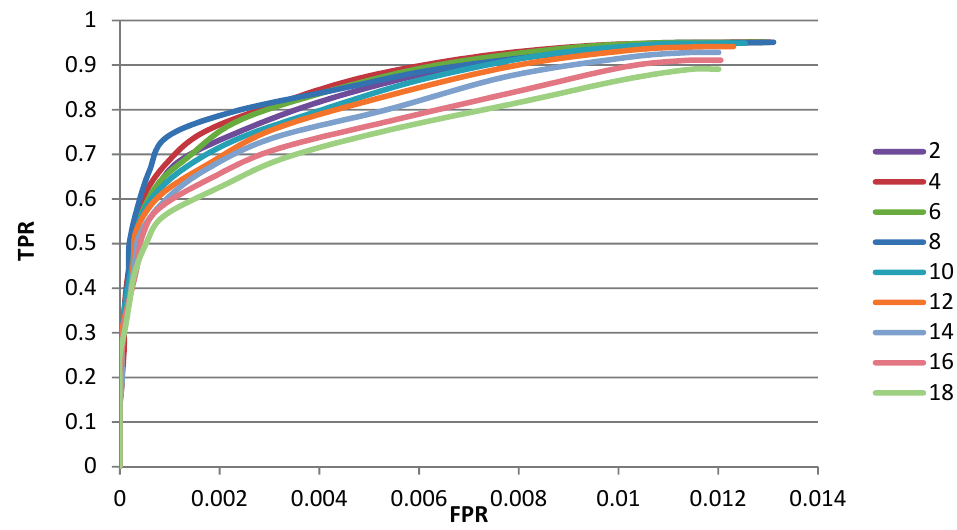
Figure 10. ROC curves by using different radius of the window (the unit of radius is pixel).